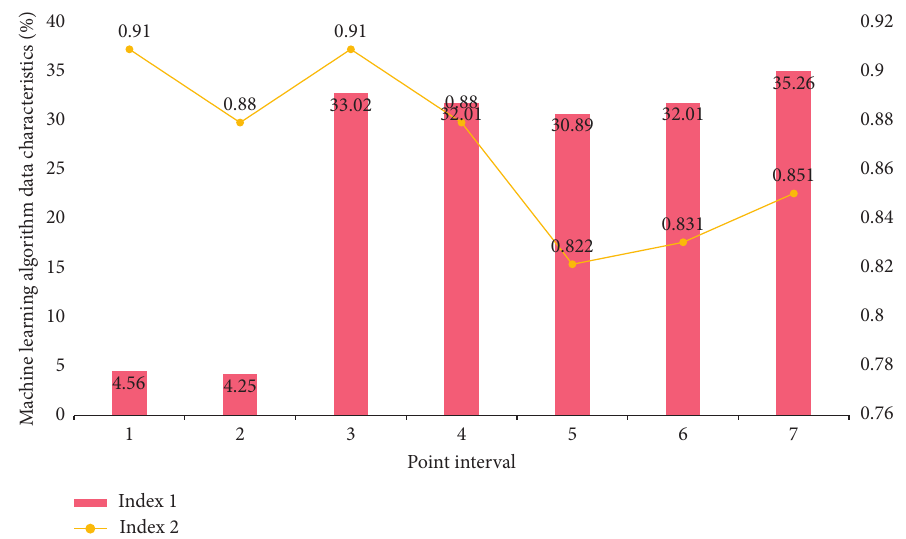
Figure 5: Machine learning algorithm data feature